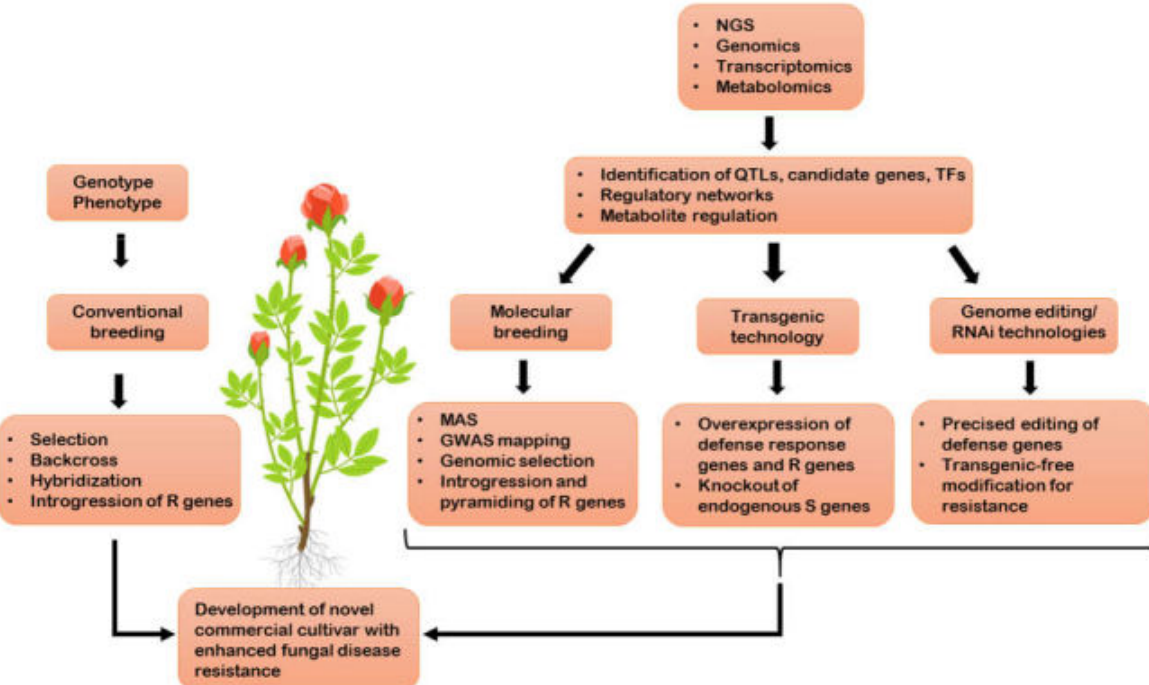
Figure 2. The comprehensive illustration of different strategies, integrating conventional and advanced breeding technolo- gies to develop novel ornamental cultivars which possess enhanced fungal disease resistance